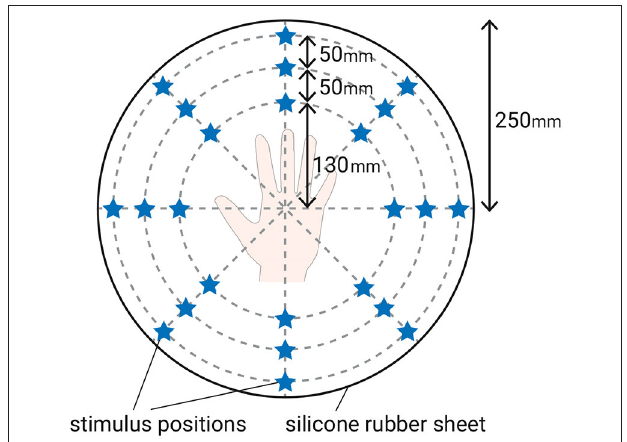
FIGURE 2 | Layout of stimuli. The star-shaped marker indicates the position of the